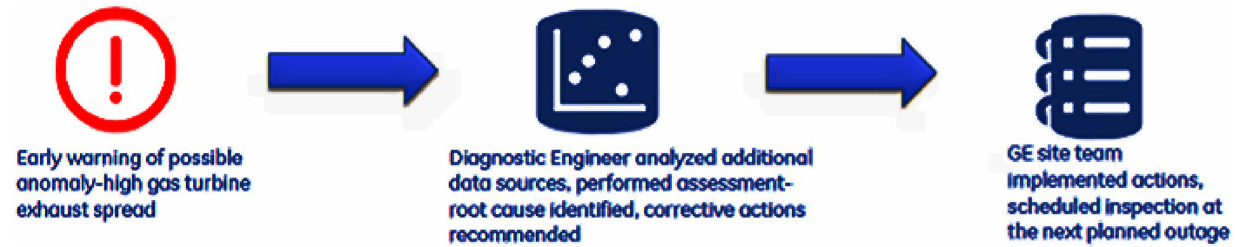
Fig. 3 GE big data diagnostics process for the LNG liquefaction industry